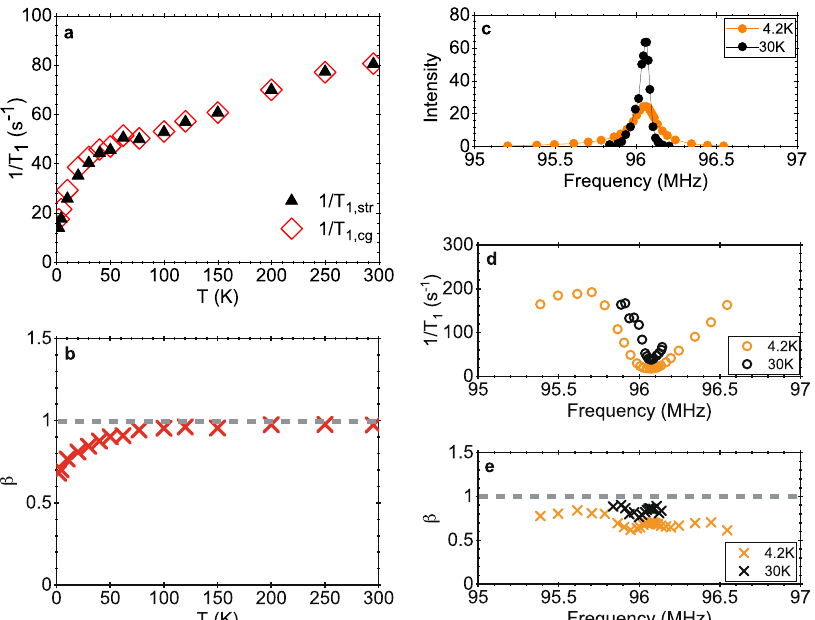
Fig. 4 Conventional stretched fi t results of 1 = T 1 ; str in Zn 0.95 . a Temperature dependence of 1 = T 1 ; str observed at 19 f peak for Zn 0.95 . For comparison, we also show the center of gravity 1/ T 1,cg of the distributed 1/ T 1 as determined from ILT. b Temperature dependence of the stretched exponent β observed at the peak. c Point-by-point 19 F NMR lineshape at 30 and 4.2 K. d , e 1 = T 1 ; str and β measured at each data point in c . Notice that 1 = T 1 ; str is enhanced at both higher and lower frequencies. β deviates from one more signi fi cantly near the center of the lineshapes, because the fast and slow contributions are